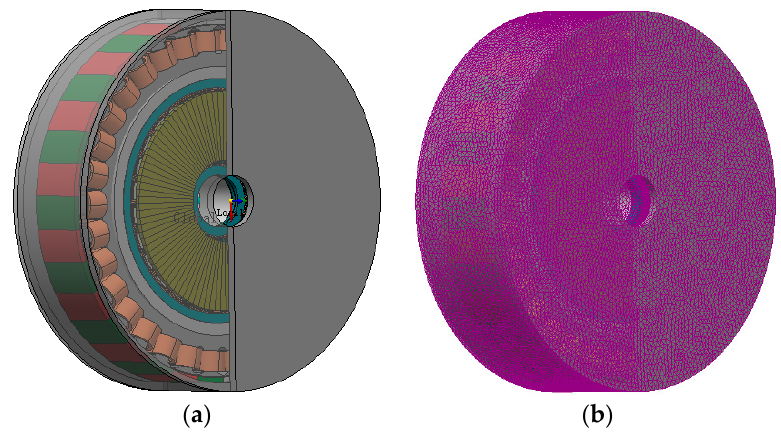
Figure 8. 3D model of the DDPMIM. ( a ) 3D FEA model; ( b ) 3D mesh. Table 3. Maximum element size of the DDPMIM.